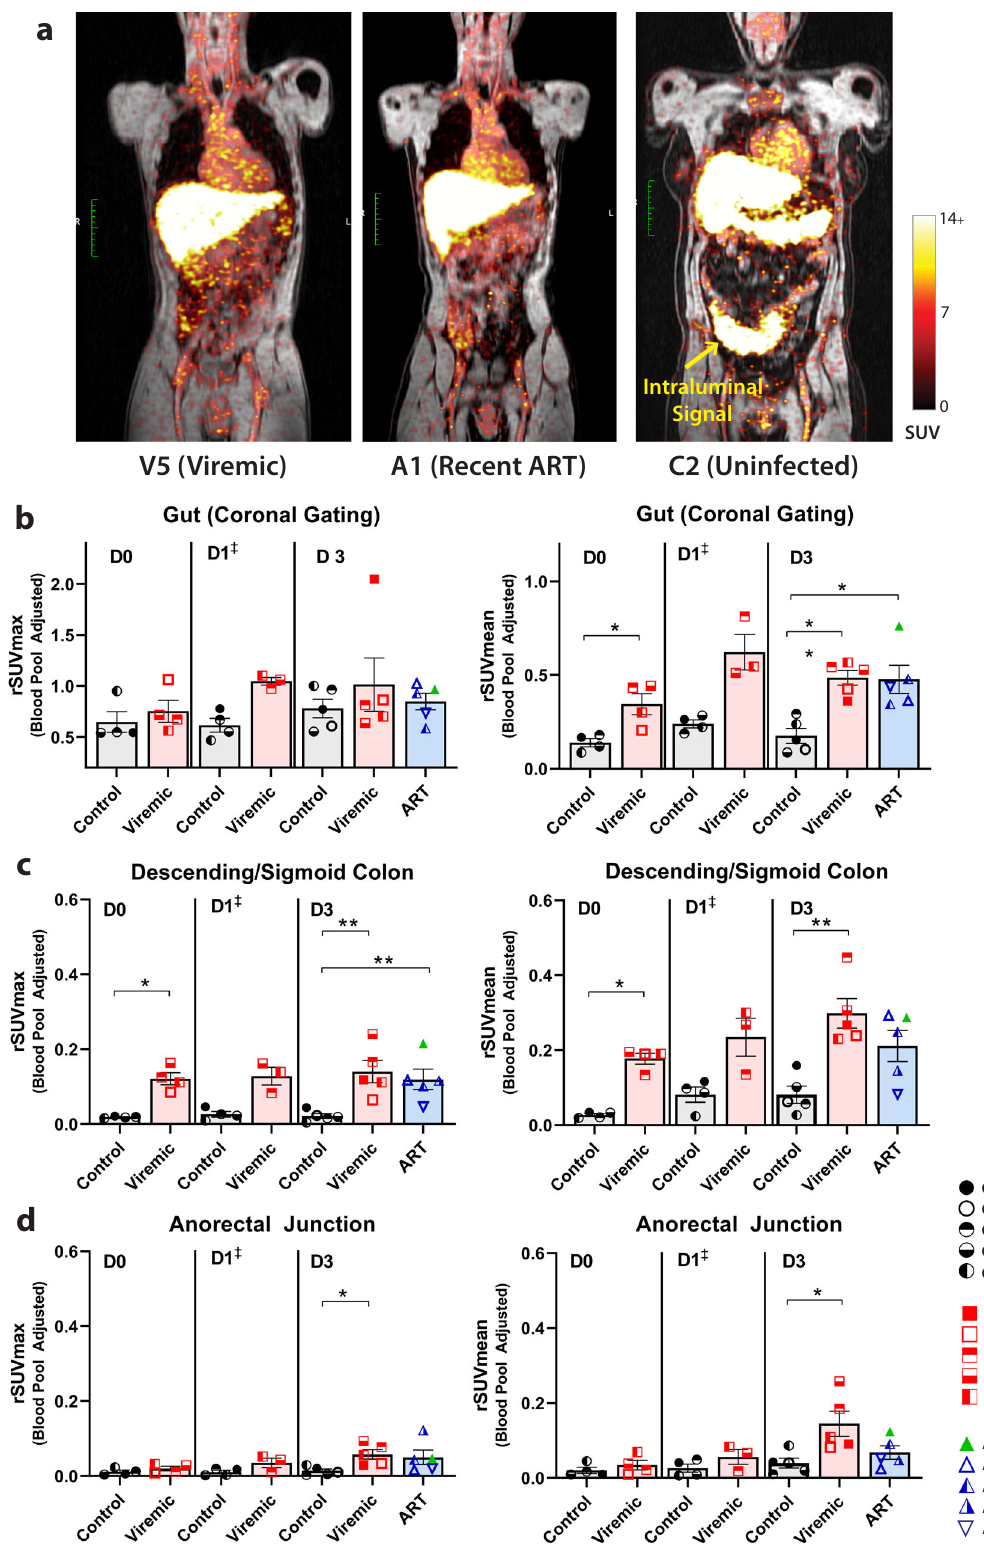
numbers of virus-infected cells. However, the PET-MR imaging technique involved led to peristalsis and gut-motion artifact which made gating challenging. Gut-associated lymphoid tissue is a major anatomical site of HIV replication, CD4 + T cell depletion in acute and early infection, and a major site of HIV persistence on ART. 27 – 31